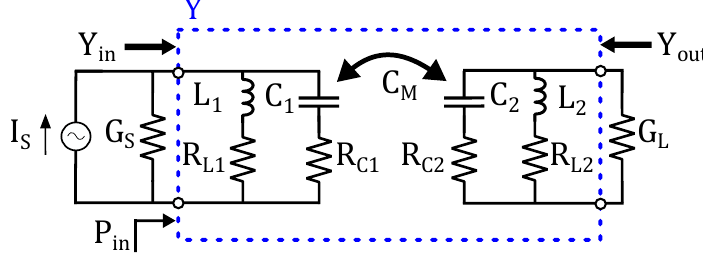
Figure 1. Equivalent circuit representation of a general capacitive wireless power transfer (CPT) system, indicating the input admittance Y in , output admittance Y out , and input power P in